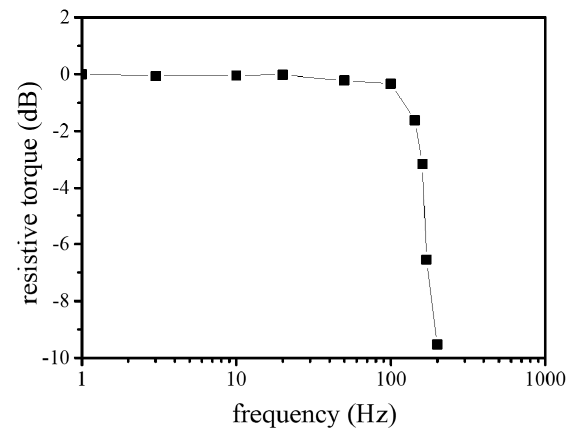
Figure 11. Measured bandwidth of the proposed haptic knob.